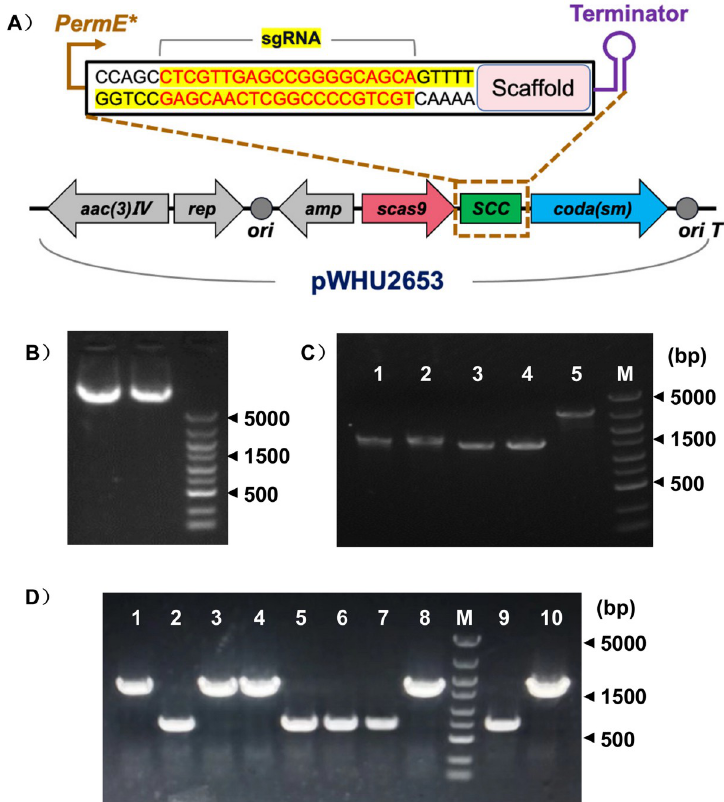
Fig 3. Generation of the asm25 -inactivated strain. (A) Schematic diagram of plasmid construction. Gel electrophoresis of pWHU2653 harboring asm25 sgRNA (both lanes). Plasmids were purified from E . coli . (C) Gel electrophoresis of homologous arms of asm25 . Lanes 1 and 2 indicate arm R, Lanes 3 and 4 indicate arm L, and Lane 5 indicates arm LR fusion. (D) Gel electrophoresis of selected double-crossover exconjugantes. The primers asm25-seq-F and asm25-seq-R were used for